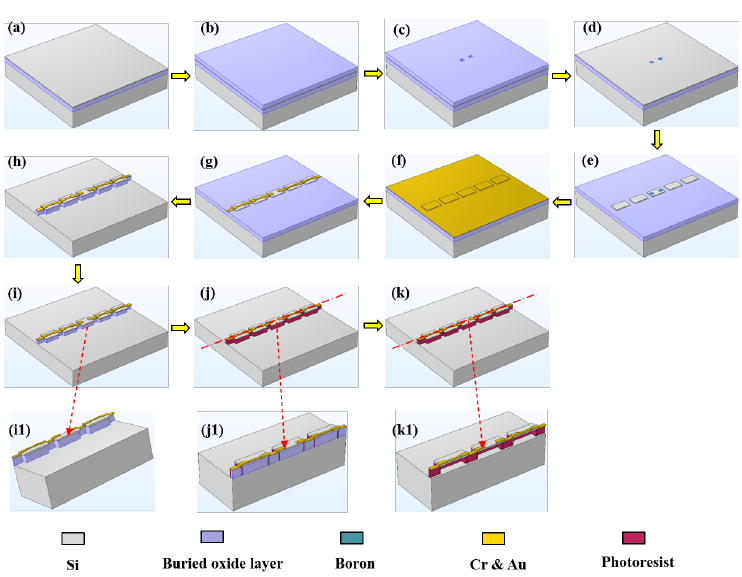
Figure 1. Process flowchart for silicon nanomembrane. ( a ) Cleaning wafers; ( b ) PECVD—1 μm SiO 2 was deposited on the wafer surface; ( c ) photoetching the ohmic contact zone and etching SiO 2 ; ( d ) doping boron and eroding impurities; ( e ) etching the piezoresistive region after photolithography; ( f ) sputtering metal and photolithography; ( g ) corroding metal and annealing; ( h ) etching the buried oxide layer after photolithography; ( i ) wet-etching part of the buried oxide layer; ( j ) photolithography and full exposure; ( k ) eroding the buried oxide layer; ( i1 ) front view of the buried oxygen layer; ( j1 ) half-section view of ( j ) along the centerline; ( k1 ) half-section view of ( k ) along the centerline.